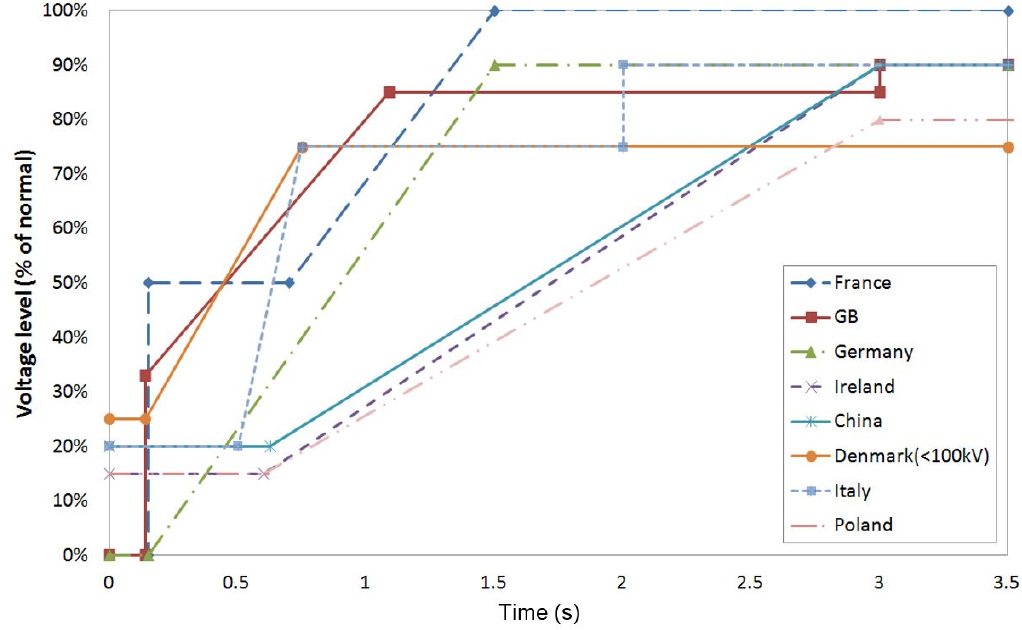
Figure 7. Comparison of the requirements of FRT/LVRT in Grid Codes [7,9–14,20–24,31,33,34].